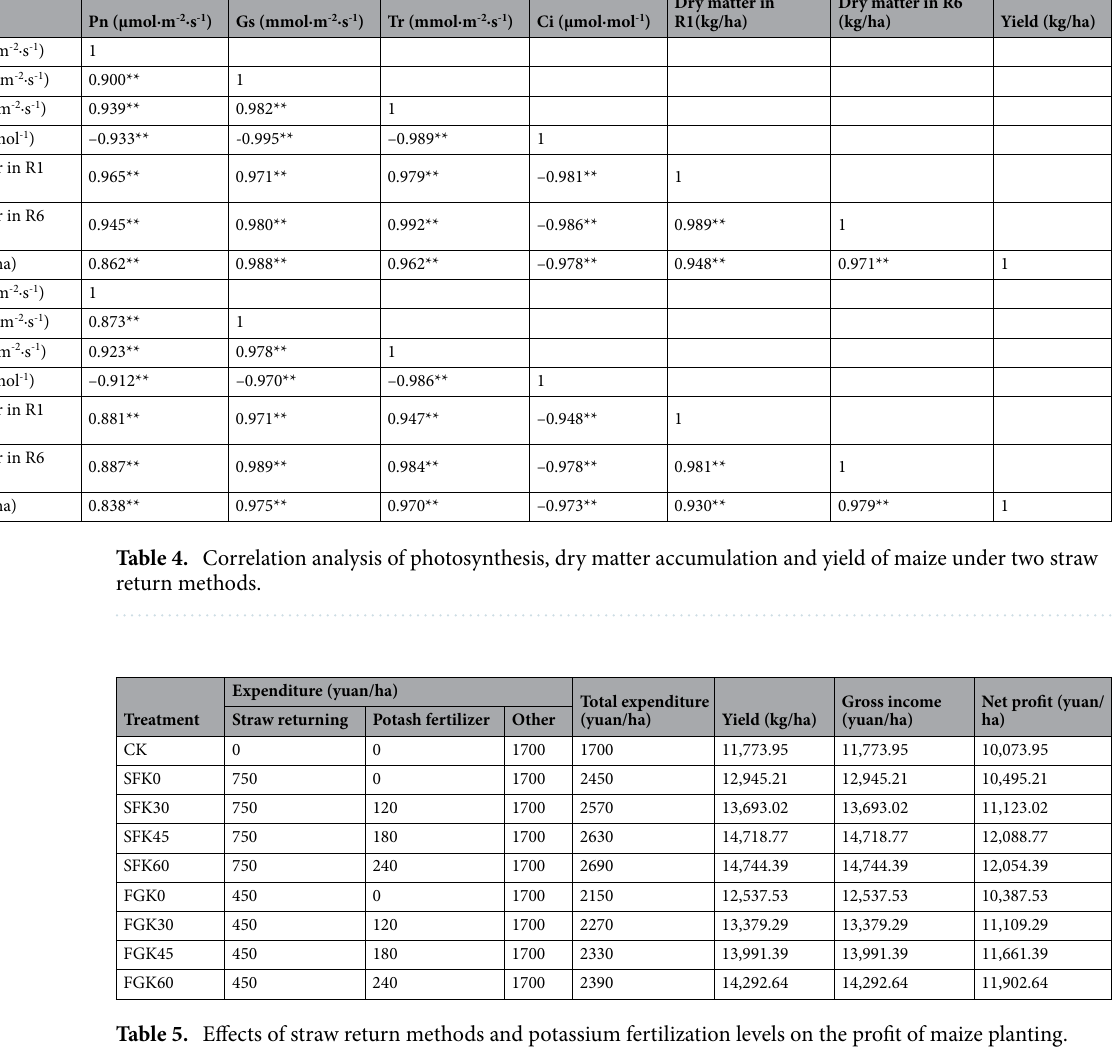
Table 5. Effects of straw return methods and potassium fertilization levels on the profit of maize